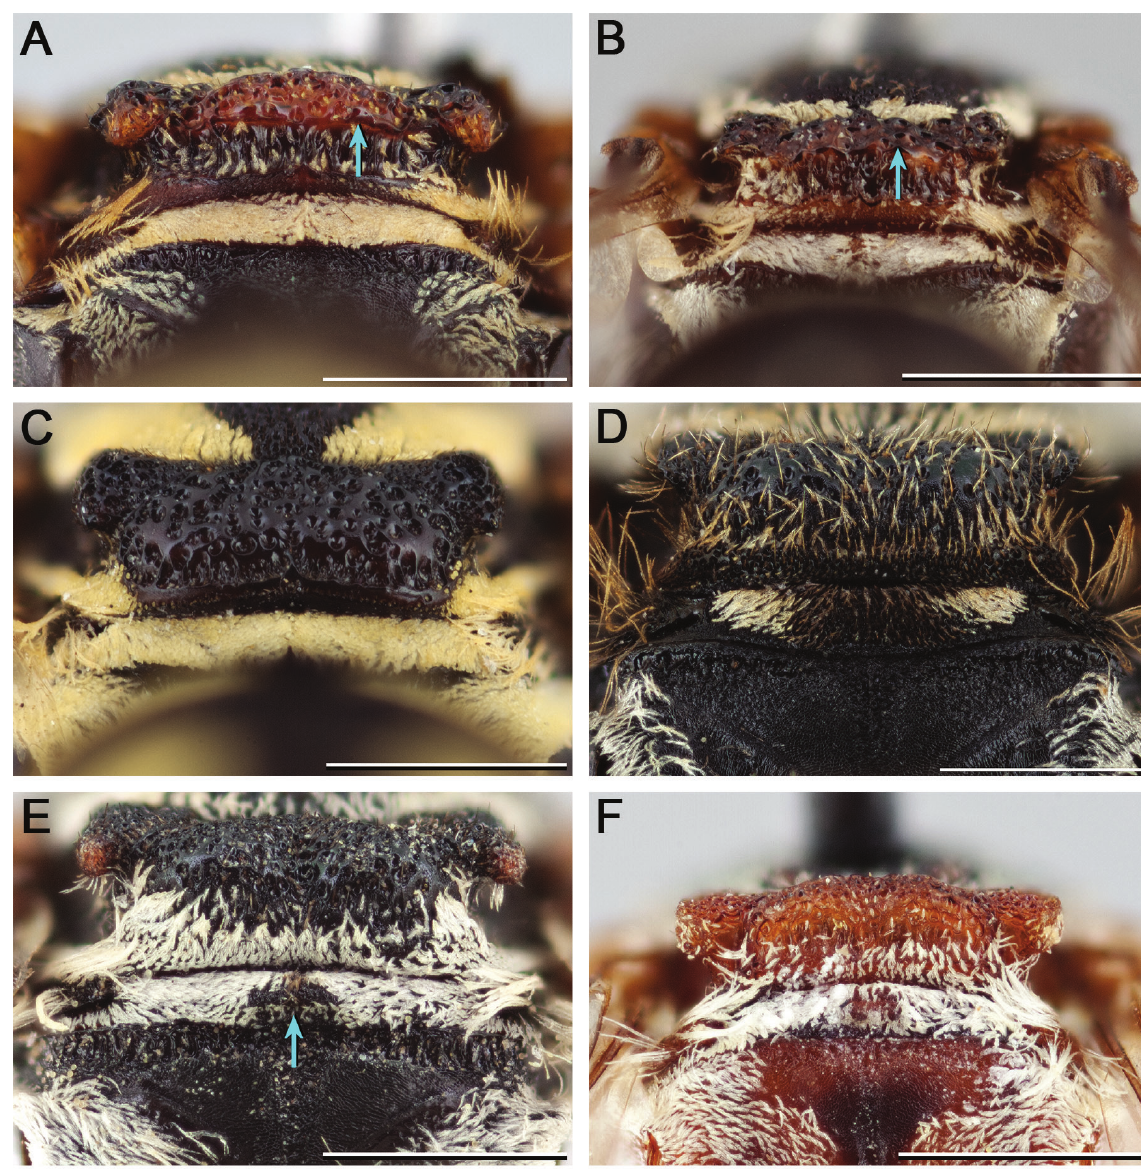
Fig. 3. Mesosoma of female, posterior view. A . E. fulvopilosus Cameron, 1902, showing mesoscutellum with a distinct ridge (blue arrow) overhanging its depressed posterior margin. B . E. fumipennis Say, 1837, showing mesoscutellum with a faint ridge (blue arrow) overhanging its depressed posterior margin. C . E. pulchellus Cresson, 1865, showing mesoscutellum without a distinct ridge delineating its dorsal and posterior portions. D . E. odyneroides sp. nov., paratype (KUNHM SEMC1248301), showing mesoscutellum without a distinct ridge delineating its dorsal and posterior portions. E . E. axillaris Onuferko, 2018, paratype, showing metanotum with a distinct posteromedial depression (blue arrow). F . E. rufulus Cockerell, 1941, holotype, showing flat metanotum. Scale bars = 1